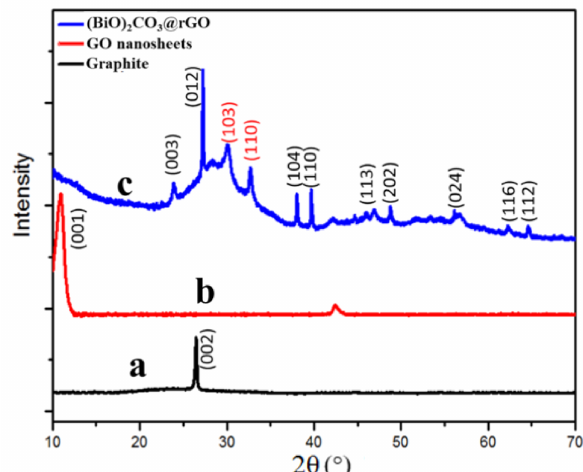
Figure 1. X-ray di ff raction (XRD) analysis of ( a ) graphite, ( b ) graphene oxide, and ( c ) (BiO) 2 CO 3 -rGO